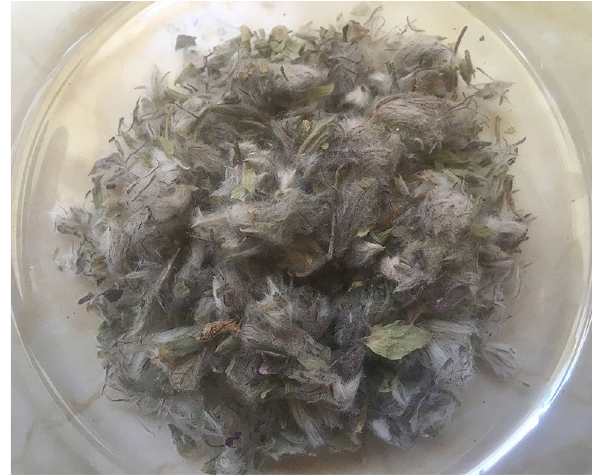
Figure 1. Image of Stachys lavandulifolia genum.